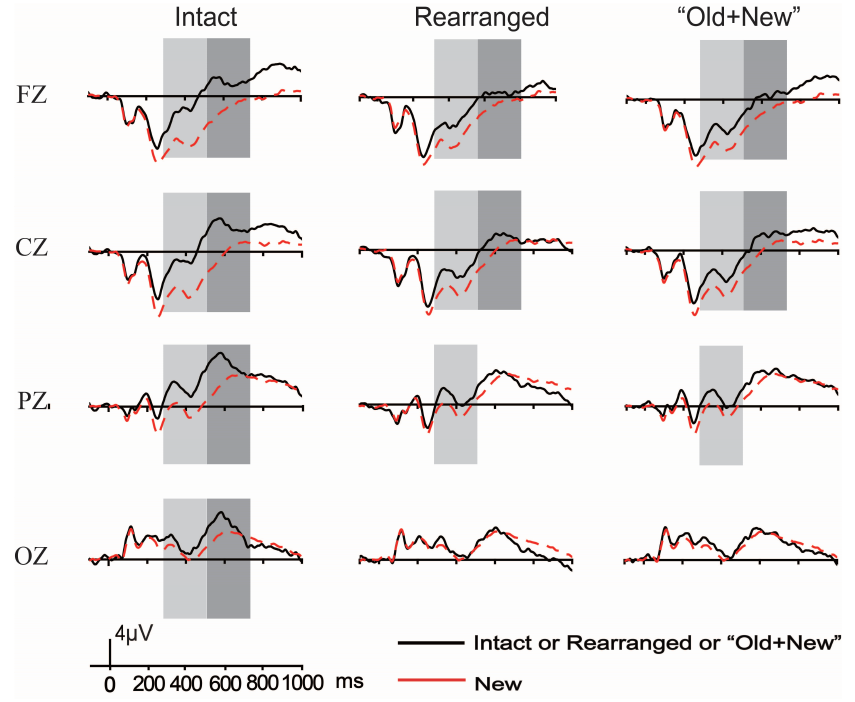
Figure 7. The grand-average ERP waveforms elicited by correctly rejected new pairs with those of correctly identified intact, rearranged, and “old + new” pairs under unrelated conditions, and the boxes mark the reliable FN400 and LPC.